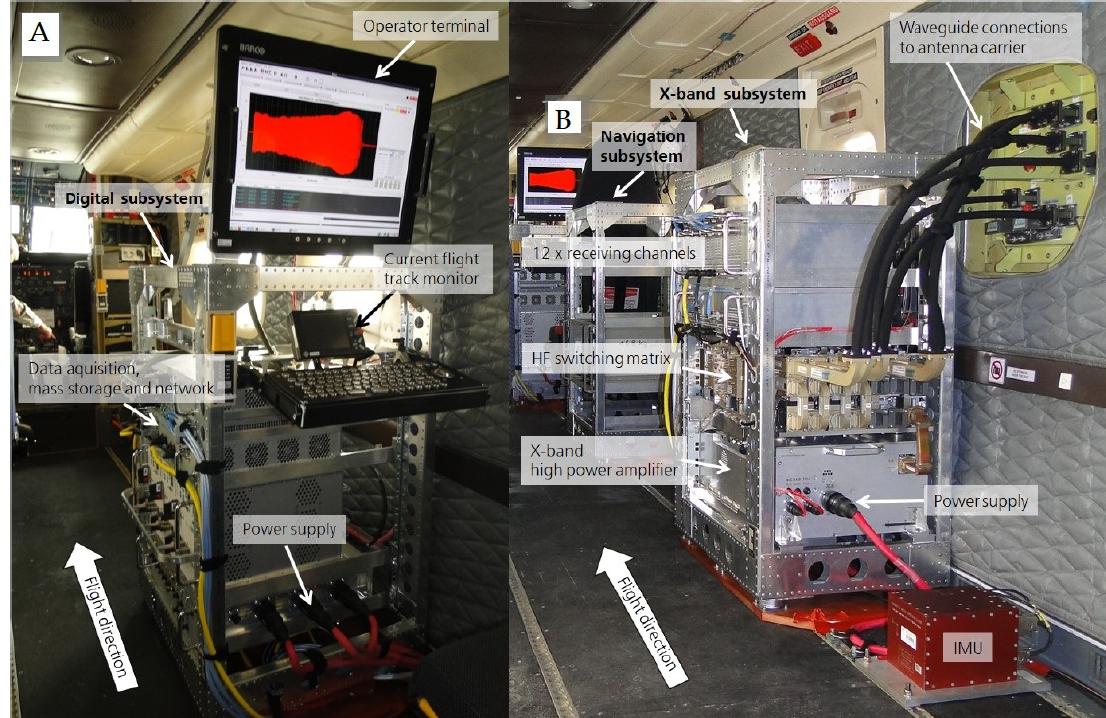
Figure 1. ( A ) DBFSAR mounted in the cabin of DLR’s Do228 aircraft: digital backend in the back, ( B ) HF front-end in the front and X-band wave-guide connections on the very right of the